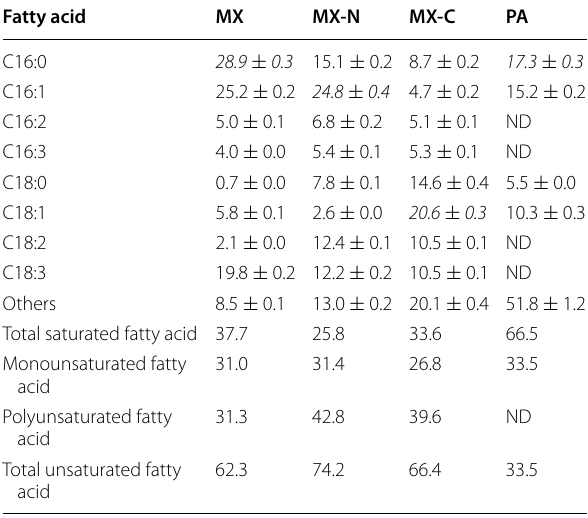
Italic values indicate maximum relative abundance of fatty acids in the